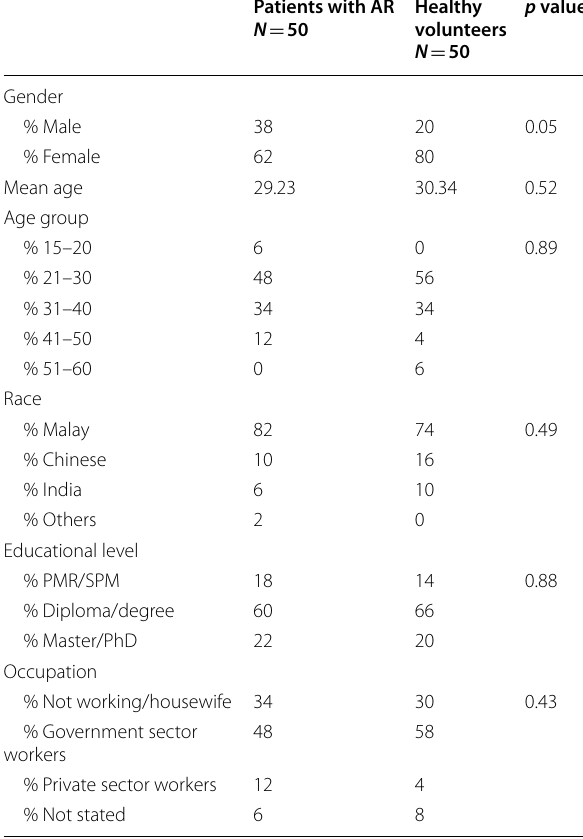
Table 1 Summary of the demographic data of participants in the present study